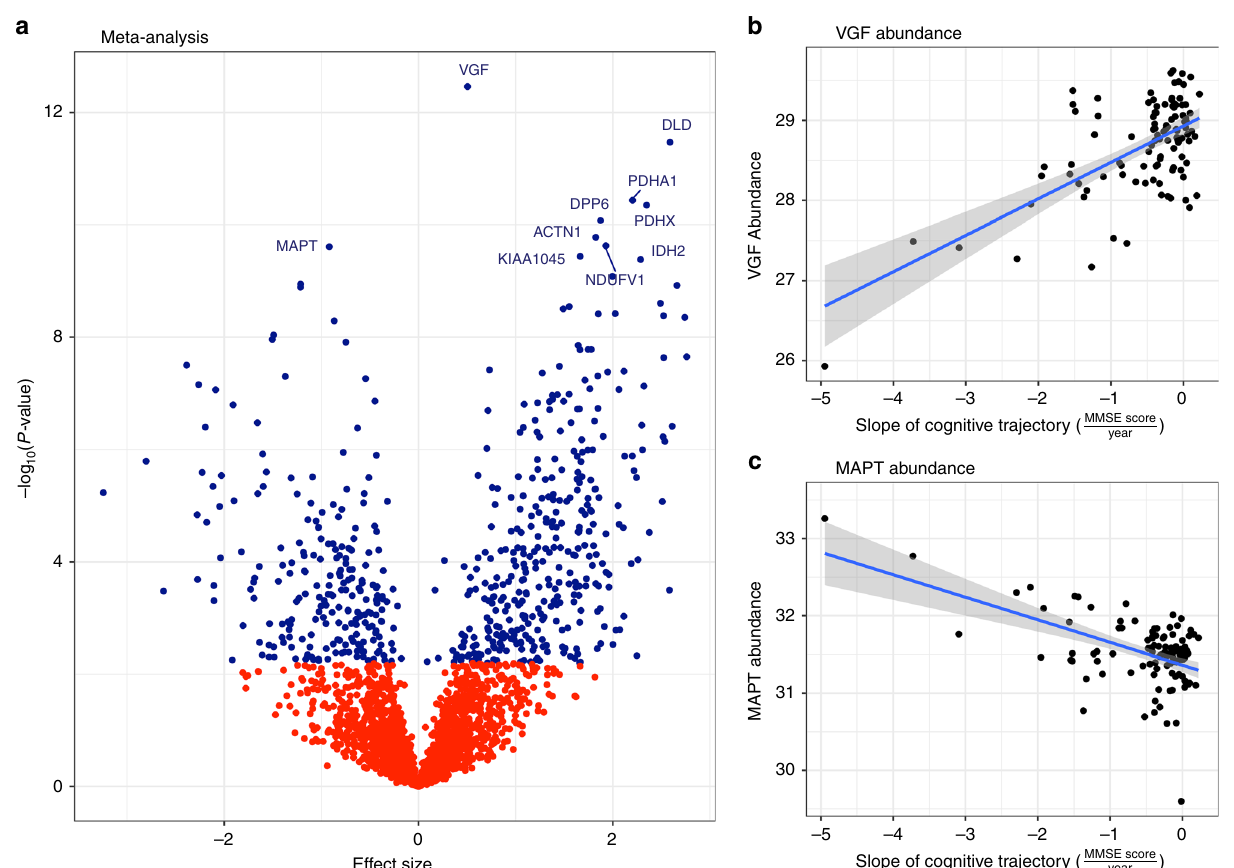
Fig. 3 Differential protein expression in cognitive trajectory. This fi gure summarizes the meta-analysis of the proteome-wide association study of cognitive trajectory in the discovery (Banner) and replication (BLSA) cohort. a Volcano plot for the meta-analysis of the proteome-wide association studies of cognitive trajectory in the discovery and replication cohorts. A total of 579 proteins were associated with cognitive trajectory at FDR < 0.05. Among these, 350 proteins had increased abundance and 229 had decreased abundance in cognitive stability. The underlying data are available as Supplementary Data 2. In b , c , protein abundance vs. slope of cognitive trajectory is plotted with the best- fi t regression line drawn in blue and the 95% con fi dence interval for the regression line shaded in gray. b Higher VGF protein level was associated with cognitive stability. Of note, for cognitive trajectory, a small negative slope re fl ects slow decline and a large negative slope re fl ects fast decline. Cognitive stability is re fl ected by a positive slope or very small negative slope of the cognitive trajectory. c Lower MAPT protein level was associated with cognitive stability. The data underlying b , c are available through the Synapse platform (protein abundance, https://www.synapse.org/#!Synapse:syn7170616 and https://www.synapse.org/#!Synapse:syn3606086) and